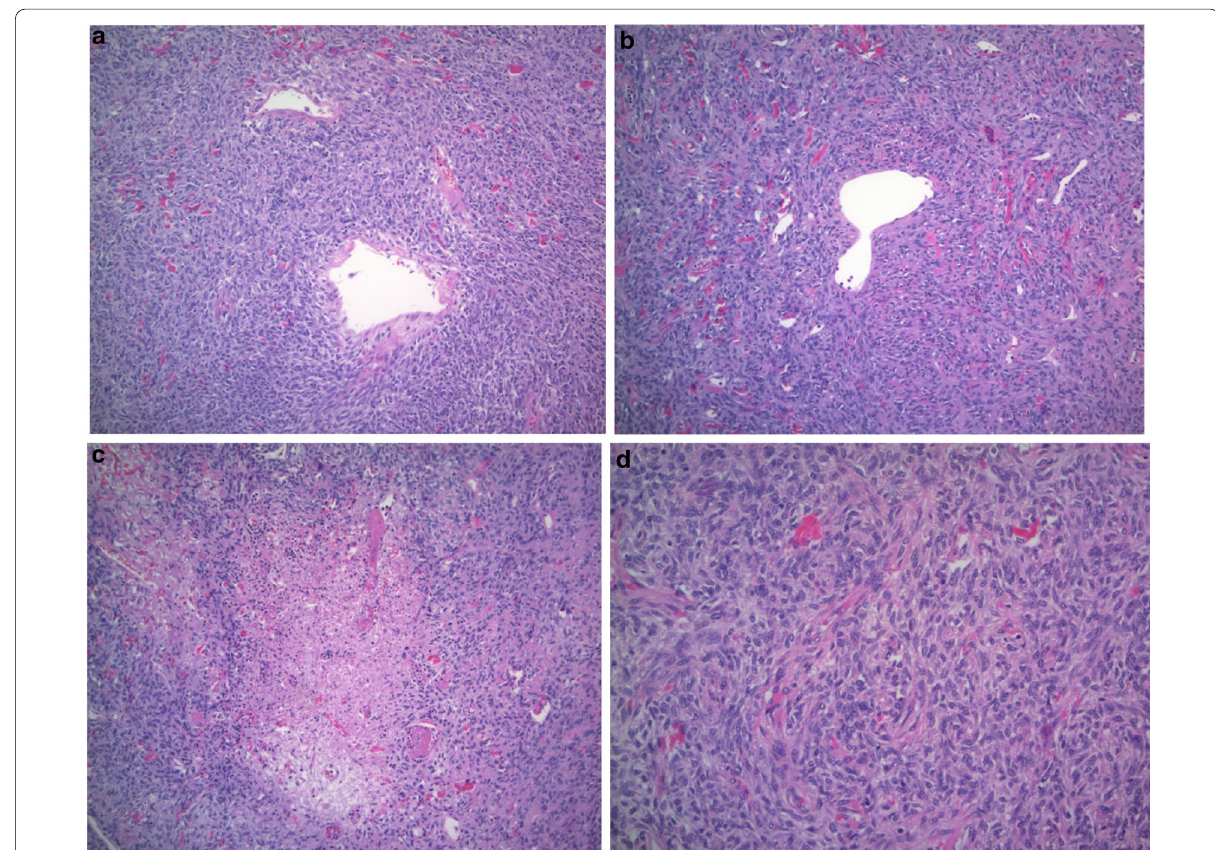
Fig. 3 Hematoxylin and eosin-stained sections: a , b thin-walled vessels with staghorn-like appearance ( necrosis ( 100 magnification power), d spindle cells and collagen deposits ( +